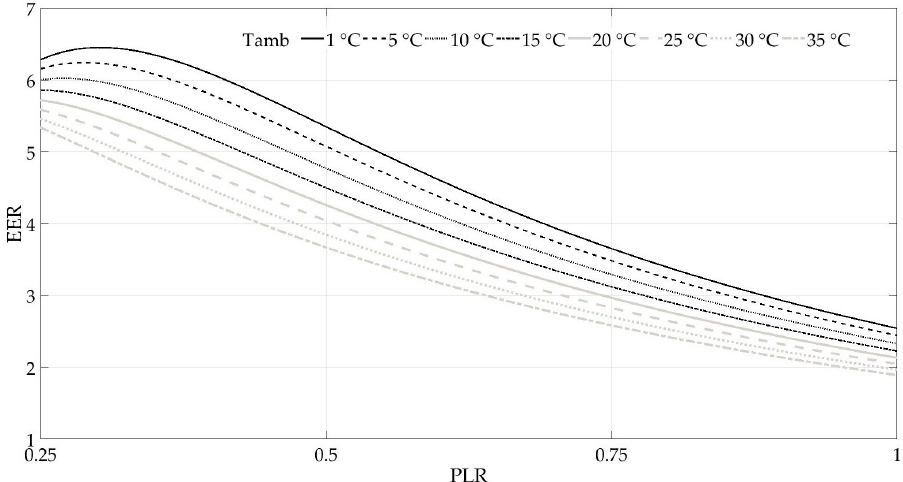
Figure 4. Part-load performance curve for air-cooled compression chiller.